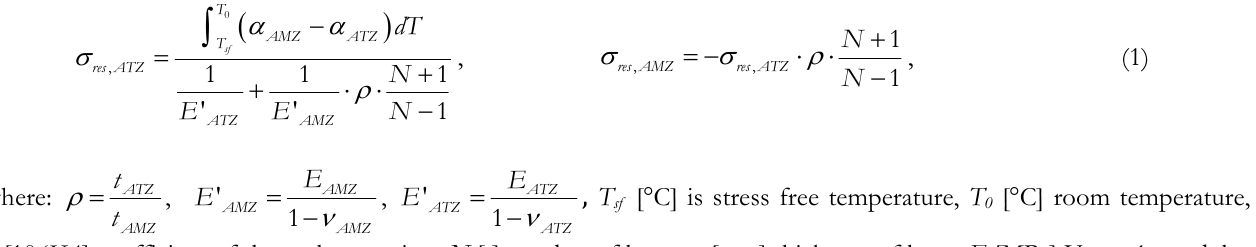
α [10 -6 K -1 ] coefficient of thermal expansion, N [-] number of layers, t [mm] thickness of layer, E [MPa] Young´s modulus